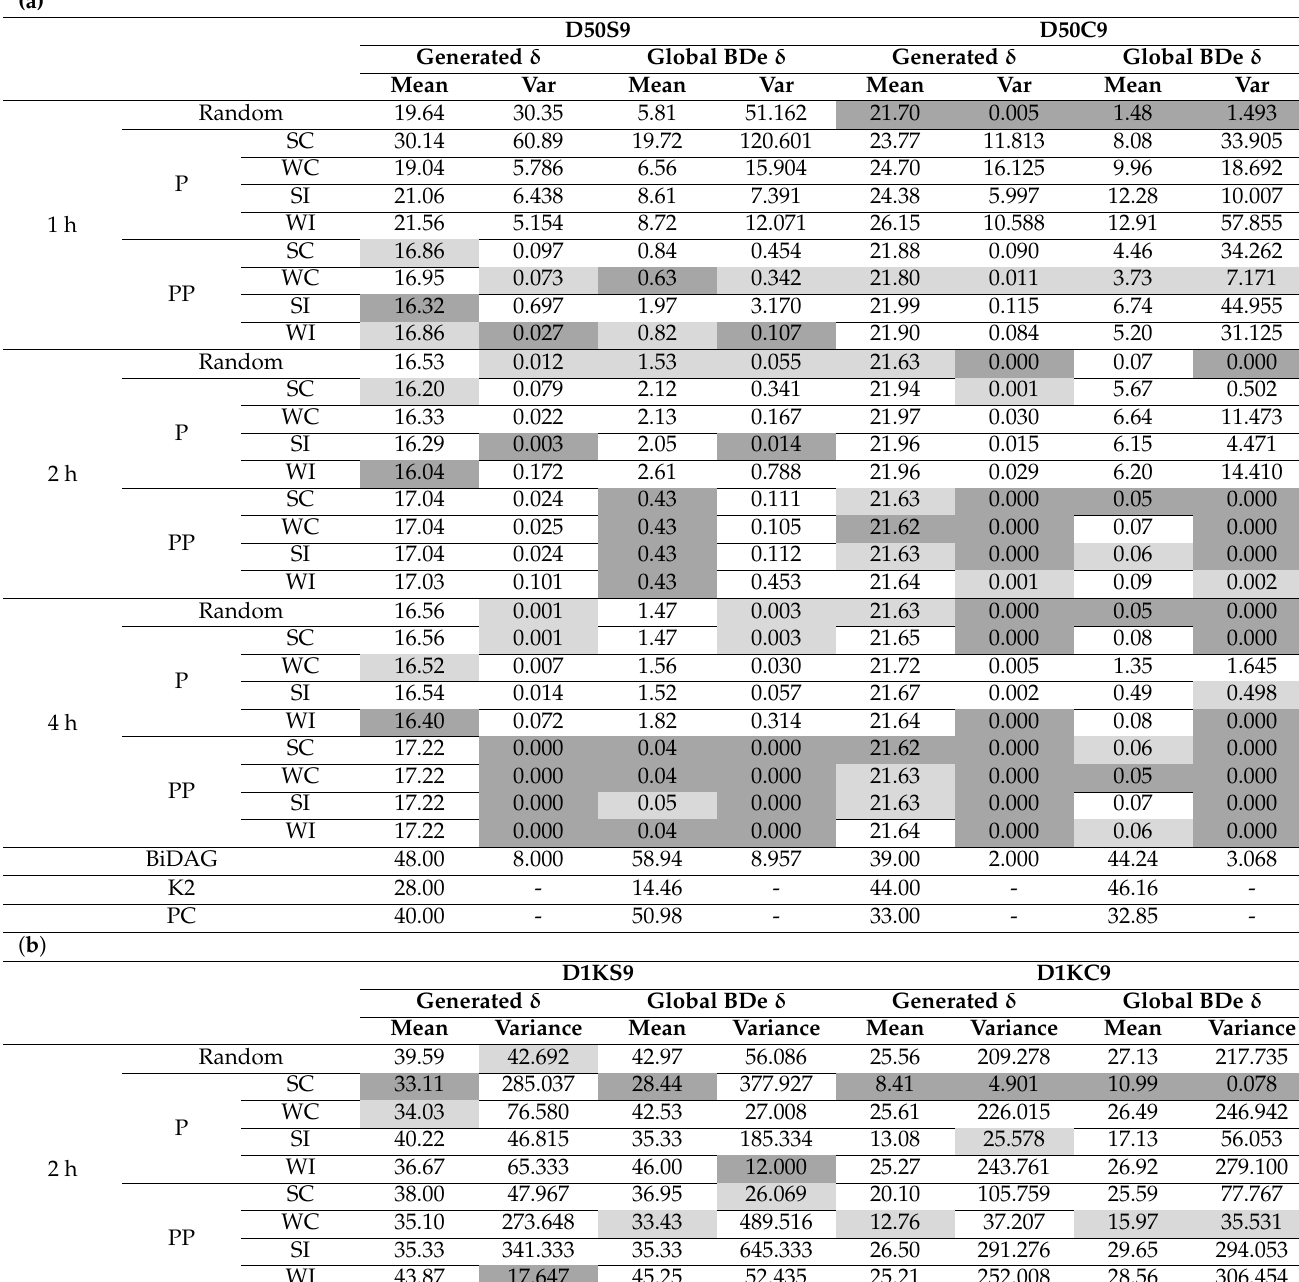
Table 5. Structure distances with the order weight. (a) 50 cases datasets. Dark shaded cells represent the lowest distance or variance in each timed run for the dataset; Bright shaded cells represent the second lowest distance or variance in each timed run for the dataset. (b) 1000 cases datasets. Dark shaded cells represent the lowest distance or variance in each timed run for the dataset; Bright shaded cells represent the second lowest distance or variance in each timed run for the